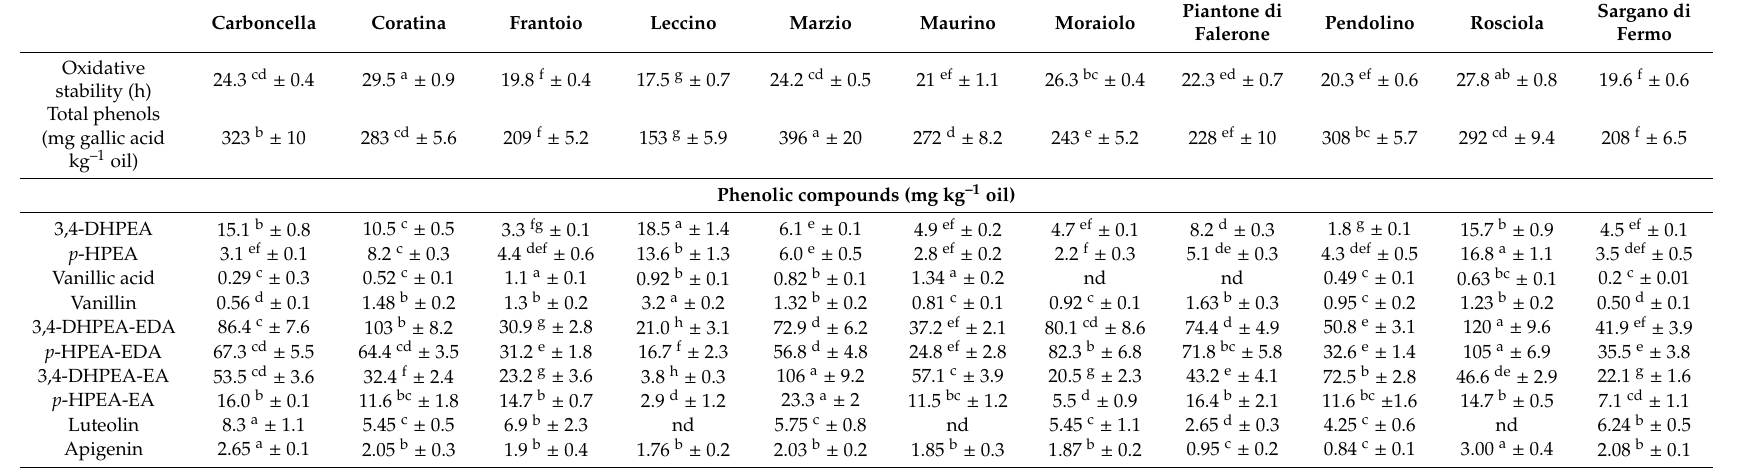
Table 4. Oxidative stability, total phenols content and phenolic profile of the eleven monovarietal extra virgin olive oils